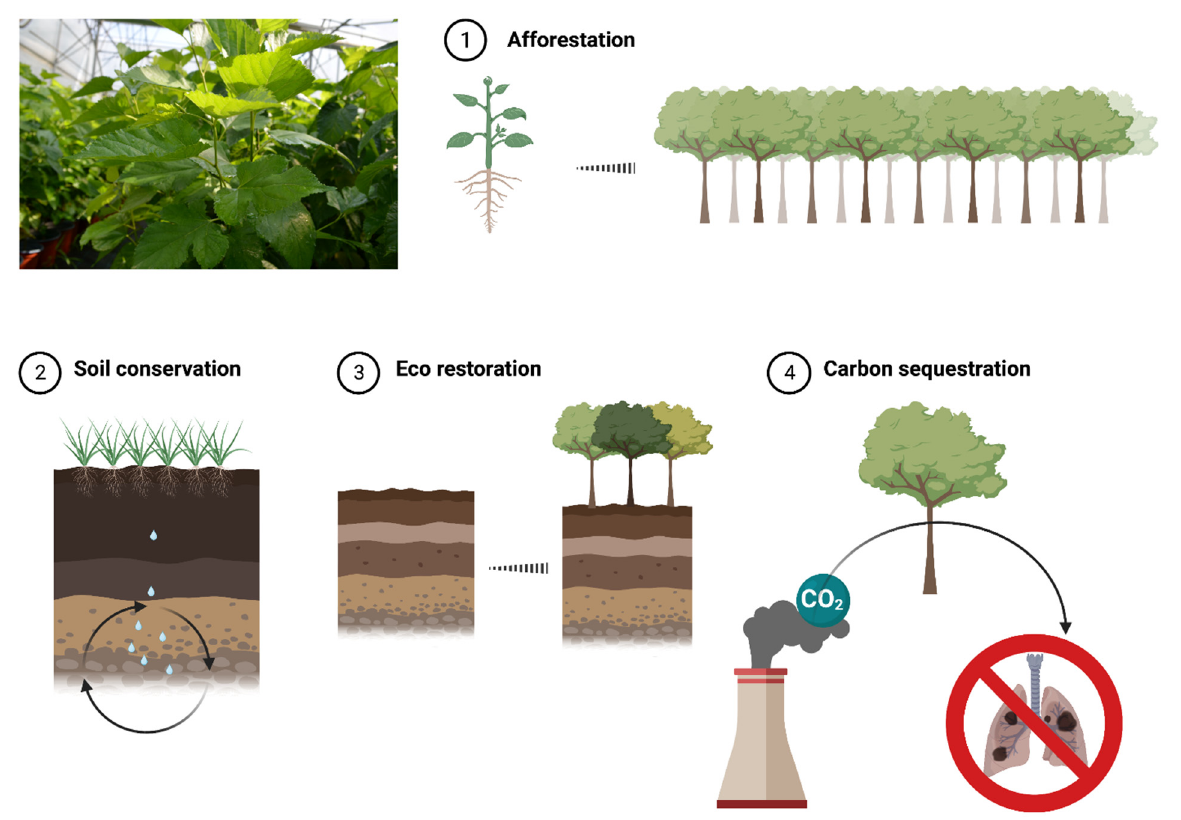
Figure 3. Importance of mulberry in environmental safety (created with BioRender.com, accessed on 10 February